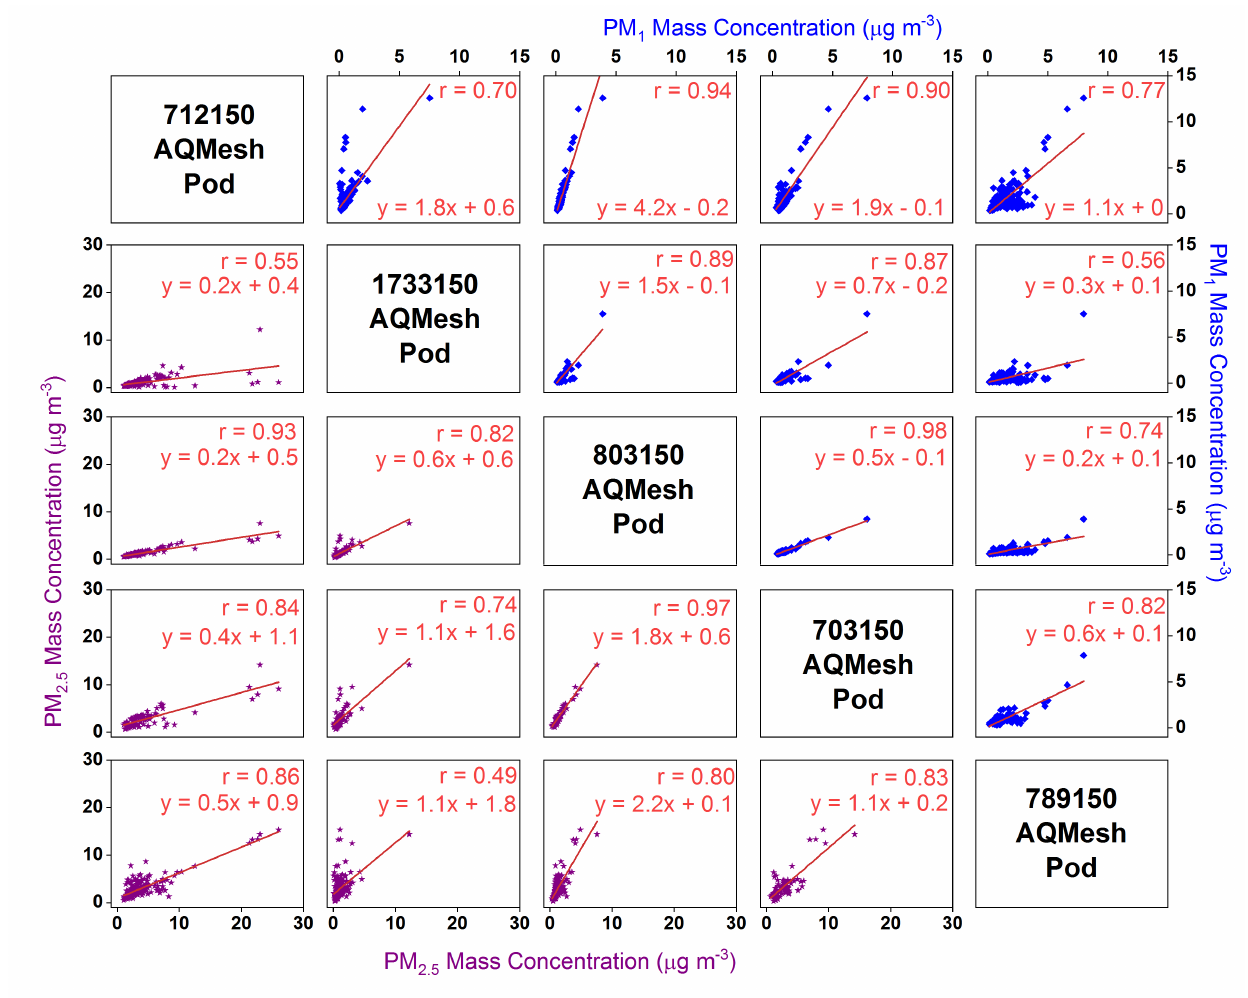
Figure 6: Scatter plot matrix of PM 1 and PM 2.5 results from co-location of AQMesh pods for eleven days in July 2017, all data are in hourly averages. PM 1 results are displayed in the ten plots in the upper triangle with data plotted in blue. PM 2.5 results are displayed in the ten plots in the lower triangle with data plotted in purple. All data presented have been processed with the correction factor outlined in Section